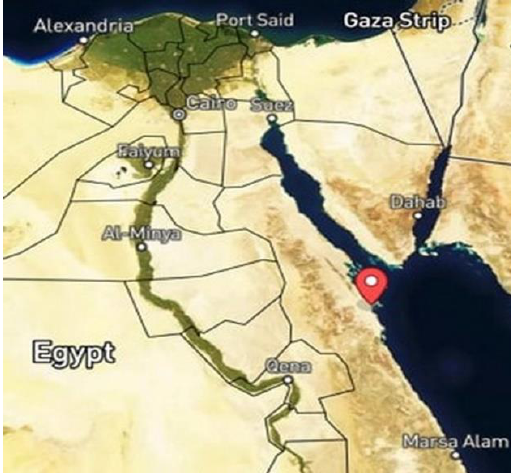
Figure 1. Map showing the location of sample collection.